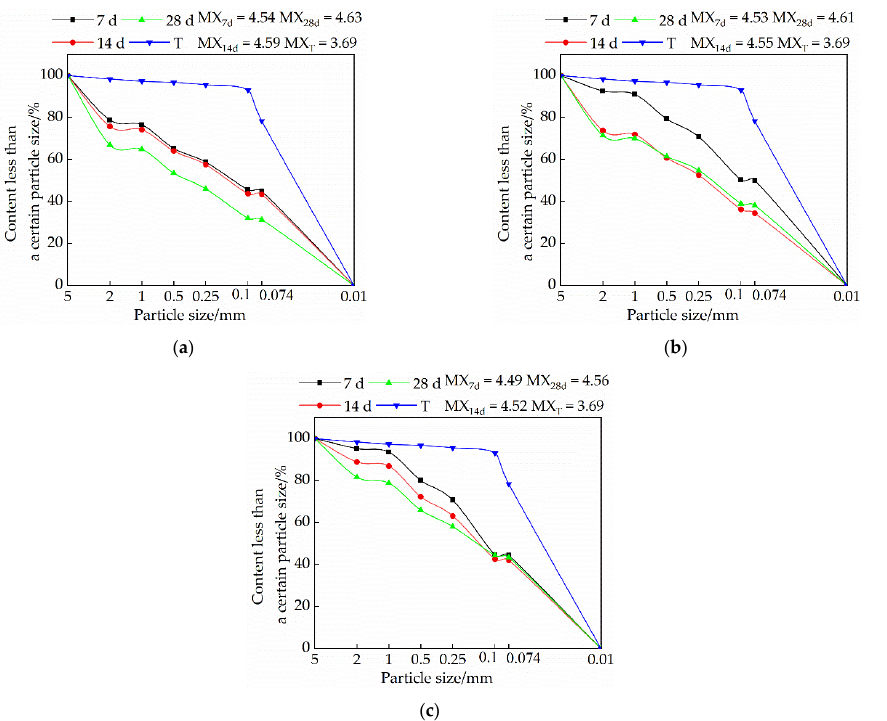
Figure 9. Influence of composite admixture on sample particle size distribution: ( a ) Particle size distribution of samples in group F1; ( b ) Particle size distribution of samples in group F2; ( c ) Particle size distribution of samples in group F3 .